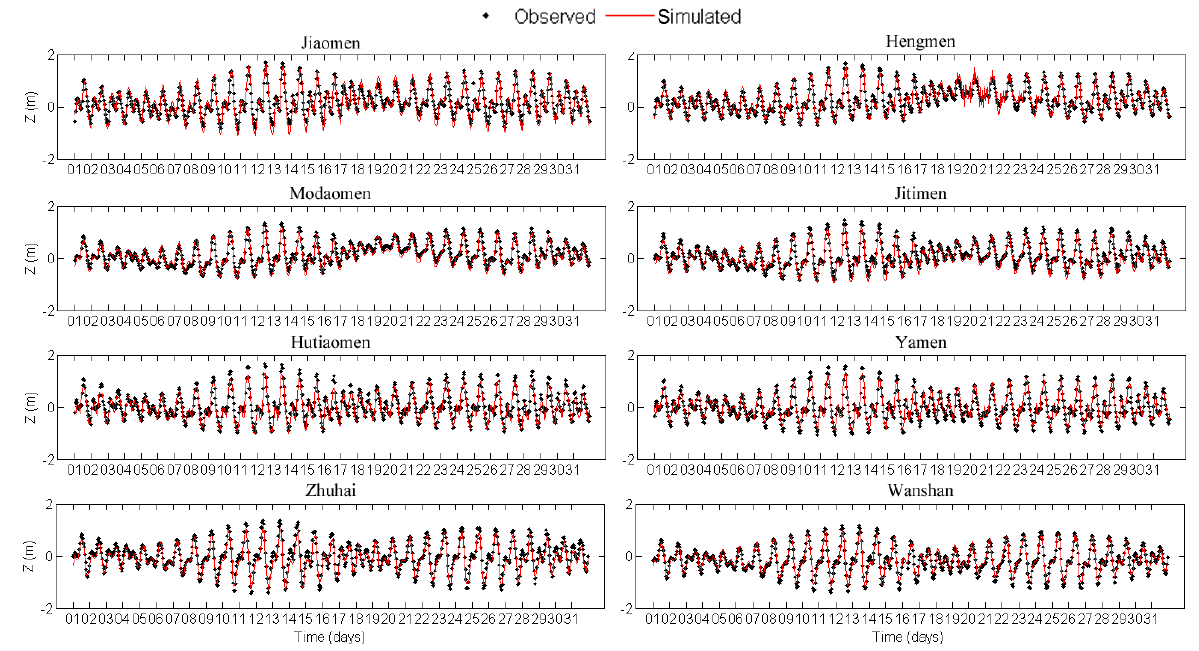
Figure 4. Comparisons of the simulated (red lines) and the observed (black dots) water levels at eight tidal stations during July 2006. Locations for the tidal stations are shown in Fig.